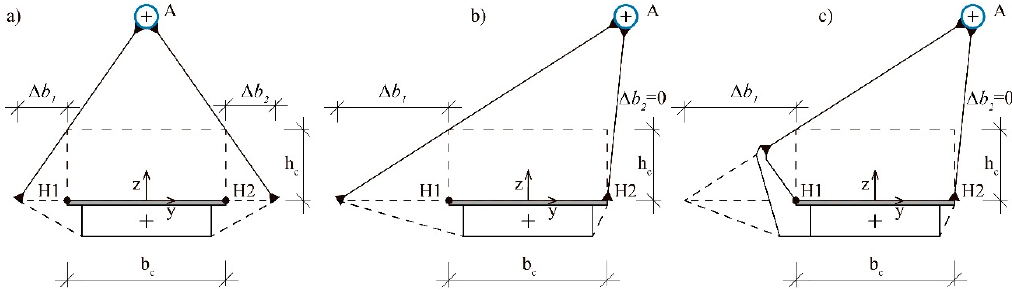
Figure 25. ( a ) Symmetric widening at each edge of the deck, ( b ) asymmetric widening, and ( c ) asymmetric widening with hangers anchored to rigid elements protruding from the deck.